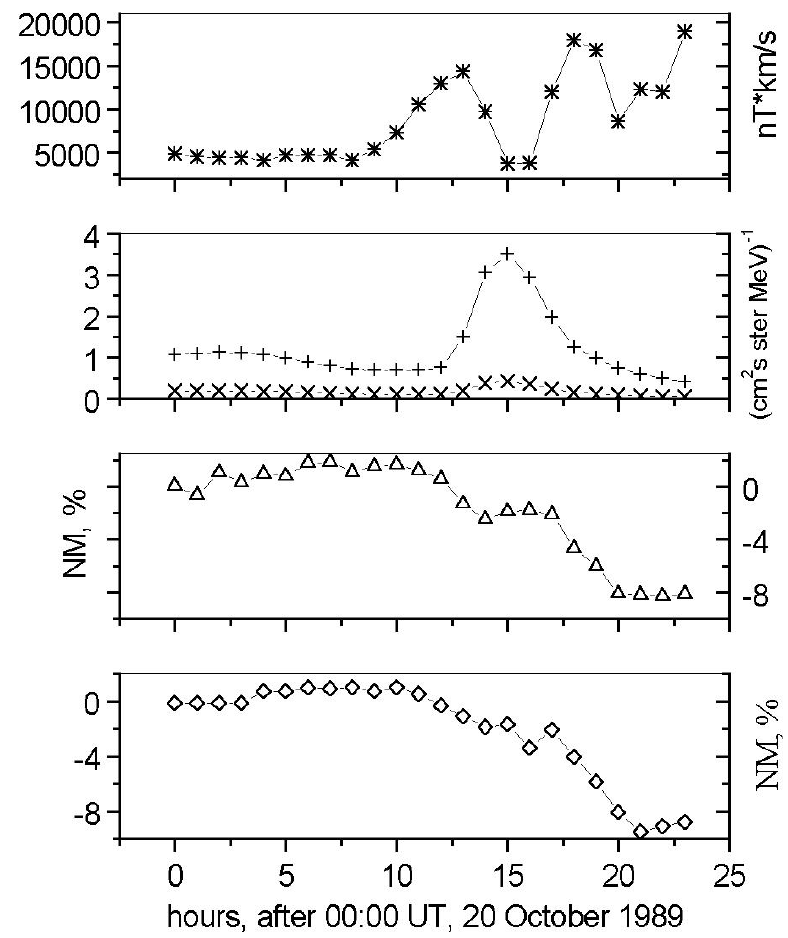
Fig. 2. The total IMP magnetic field strength (nT) multiplied by the so- lar wind velocity (km/s); proton flux within 84–200 and 110–500MeV en- ergy bands measured by the GOES- 7 detector; variations of interplane- tary origin estimated for the Apatity (open triangles) and Moscow (open di- amonds)